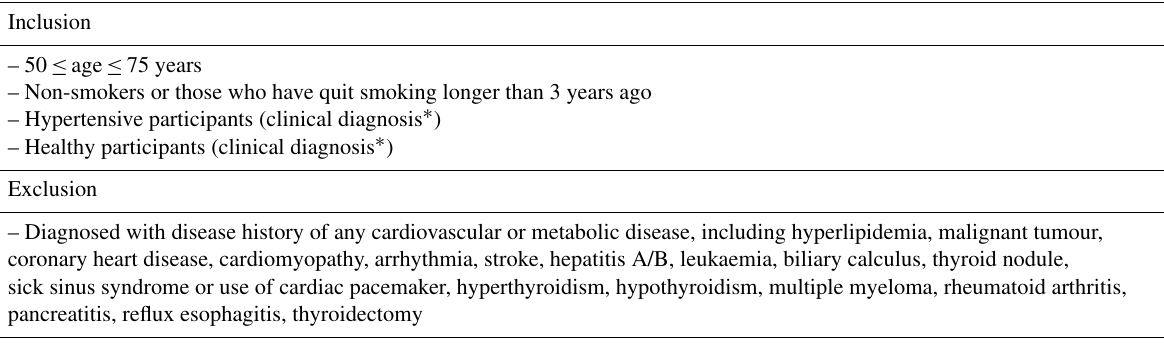
Figure 2. Locations of the two cohorts and three monitoring sites in urban and peri-urban Beijing. The figure is based on Google Maps © Google Maps. Table 1. Recruitment criteria.